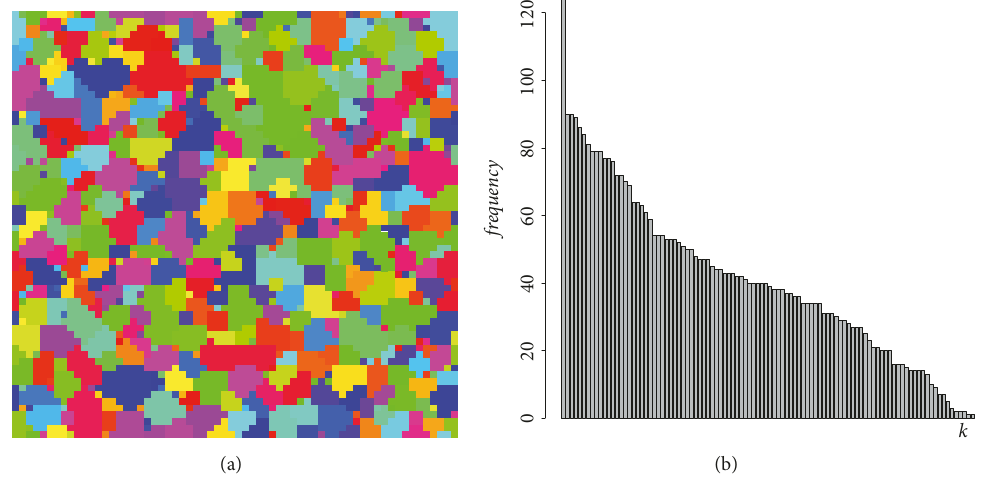
Figure 8: Example of a fixed point solution for 𝑠 = 2 , 𝑝 𝑎 = 0.75 , and 𝑝 𝑏 = 0.25 . (a) The spatial patterns of selected schools (the colormap labels the states {1,2,. .. 100} ). (b) The distribution of the number of students per